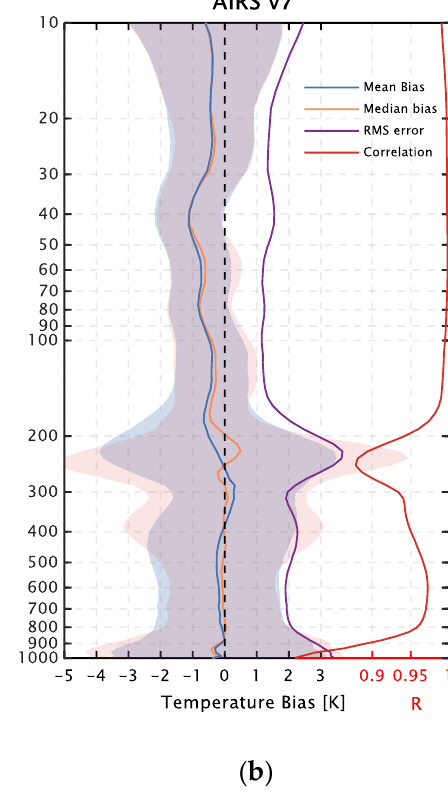
Figure 3. The mean, median, and root mean square biases for the AIRS v6 ( a ) and v7 ( b ) temperature profiles relative to simultaneous radiosonde measurements as a function of pressure averaged over 3 Arctic radiosonde sounding sites. The sonde temperature profiles are interpolated to the AIRS pressure levels using the corresponding AIRS averaging kernel. The 1 σ variation (interquartile range) is shaded in blue